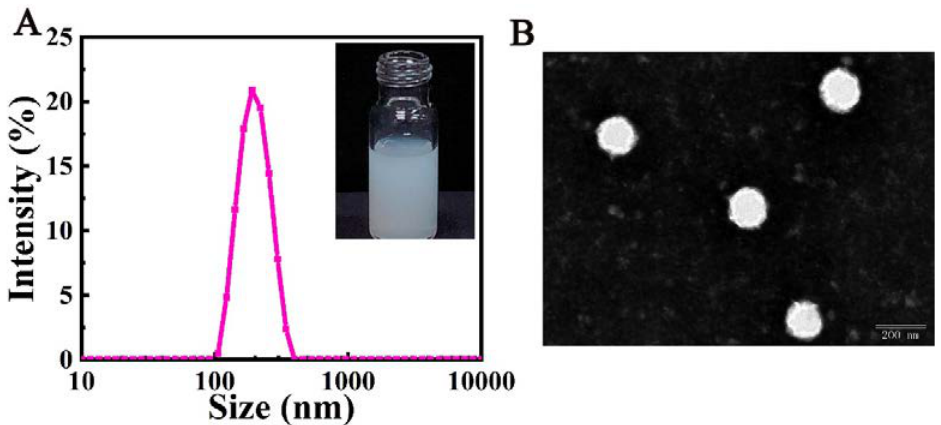
Figure 1. Characterization of ASSO-NPs. ( A ) Size distribution and appearance of ASSO-NPs. ( B ) Morphology of ASSO-NPs.